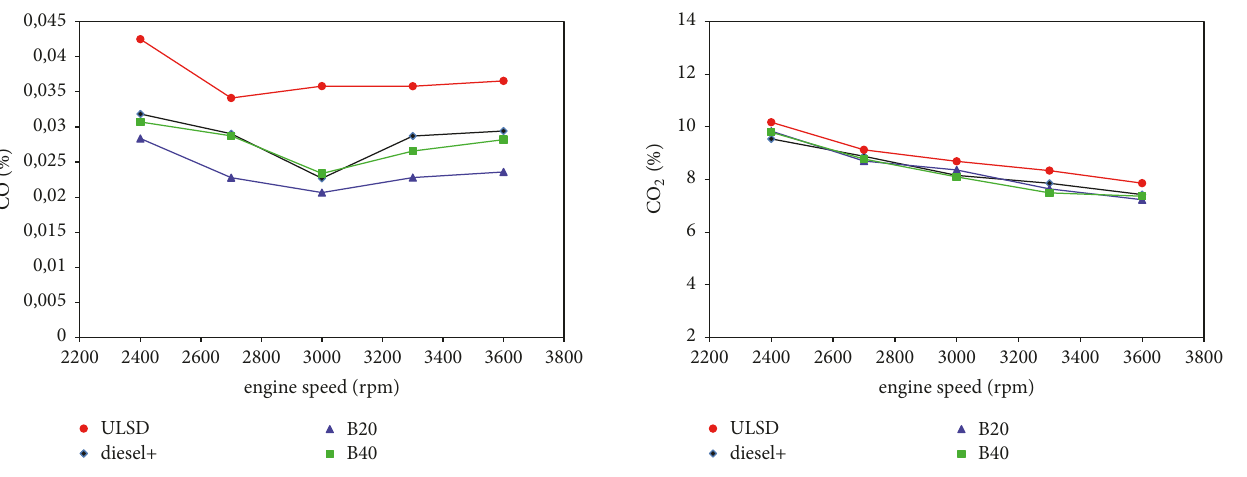
Figure 8: CO 2 variation with engine speed at 80% load.